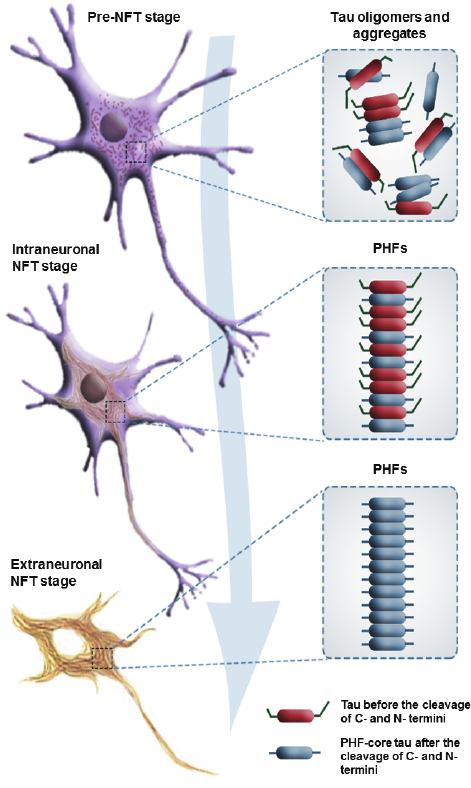
Figure 4. The sequence of cytoskeletal changes due to the pathology of tau protein divided into three stages: pre-tangle (pre-NFT) stage, and intraneuronal and extraneuronal stages. See text and Figure 5 for details.